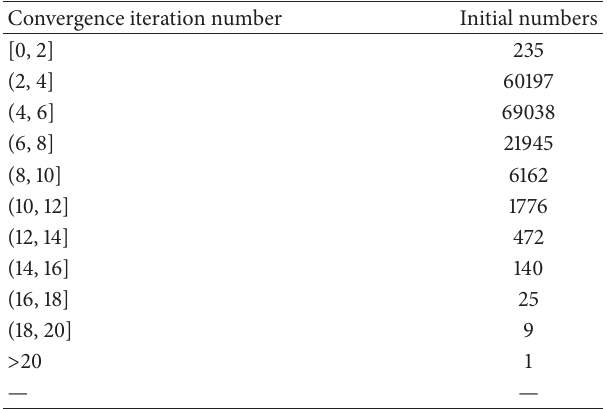
Figure 2: Convergence region of each power flow solution of a modified 3-bus test system.